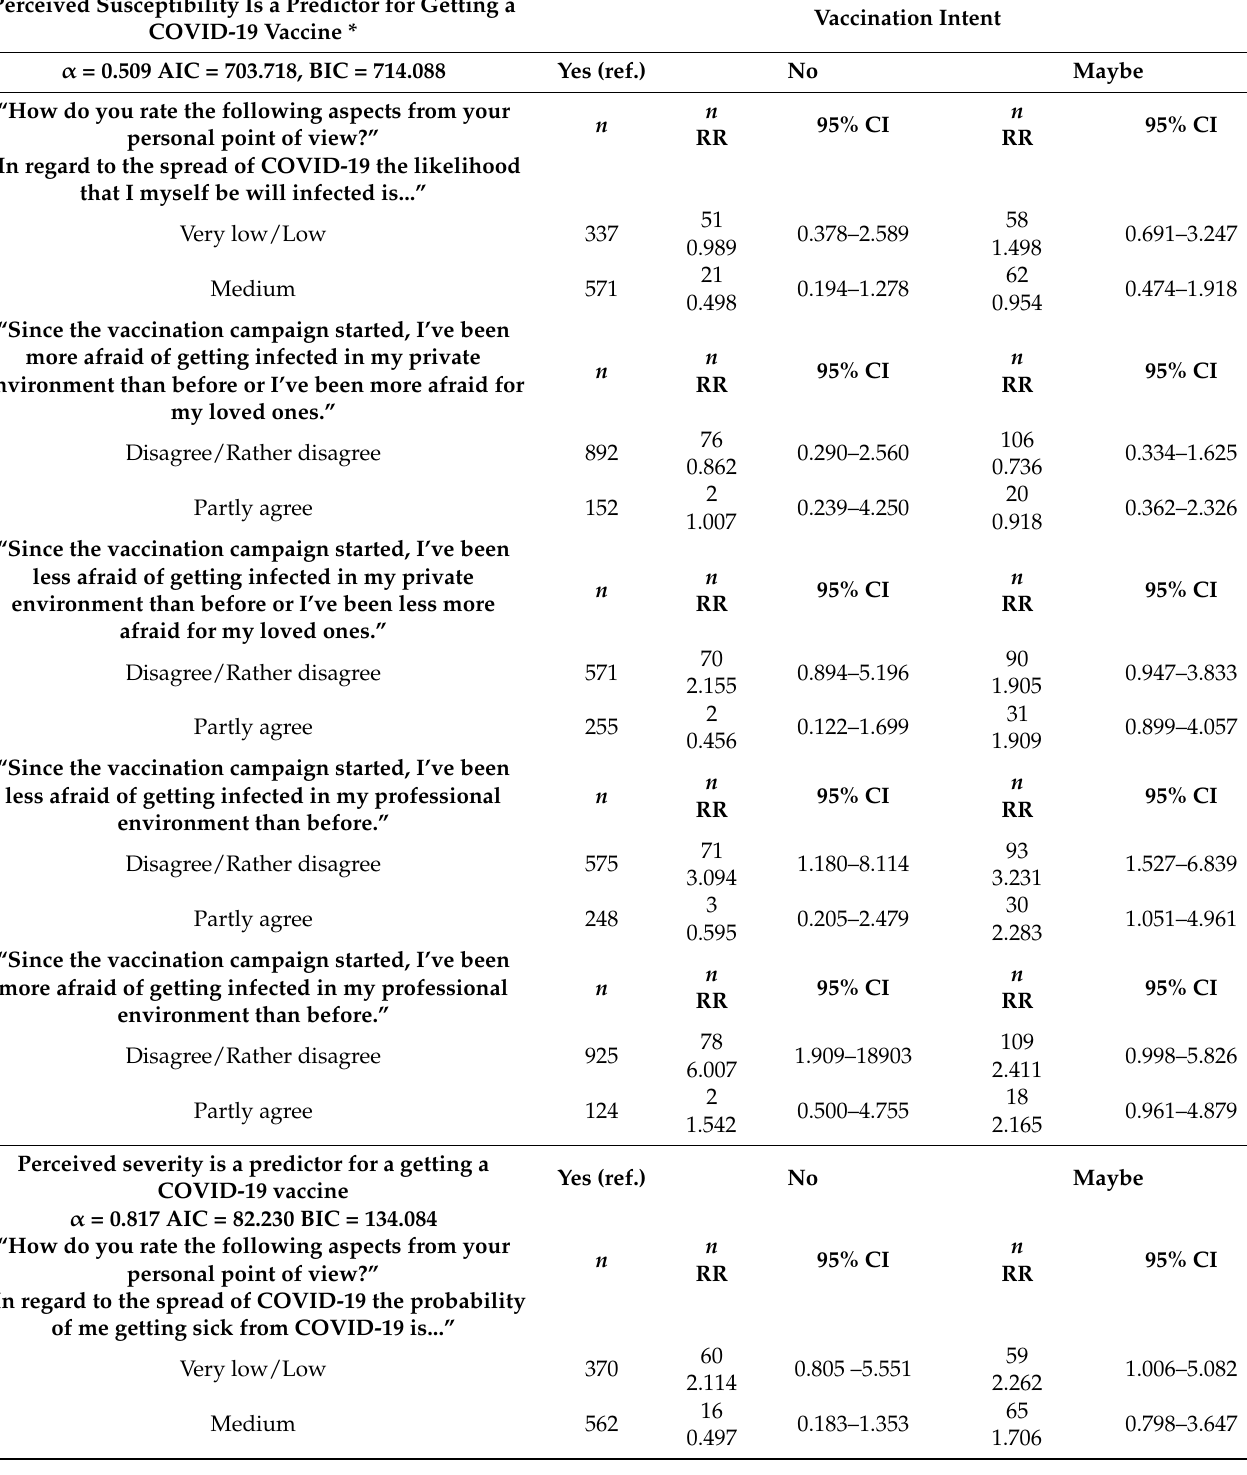
Table 6. Multinomial logistic regression models with the Health Belief Model factors associated with intent to receive a COVID-19